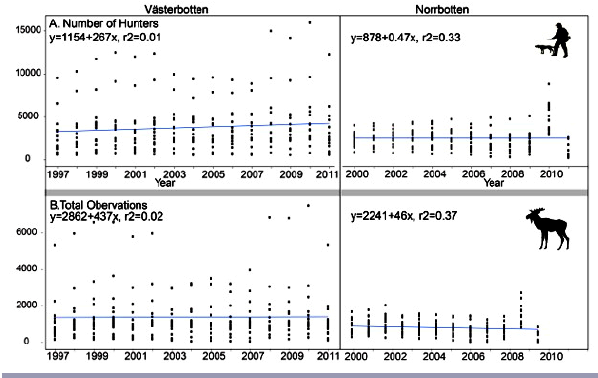
Fig. 2 . Temporal trends in (a) the number of hunters registered within the two counties of Västerbotten and Norrbotten in Sweden, and (b) the total observations of moose reported in these counties. The fitted line is based on a linear regression